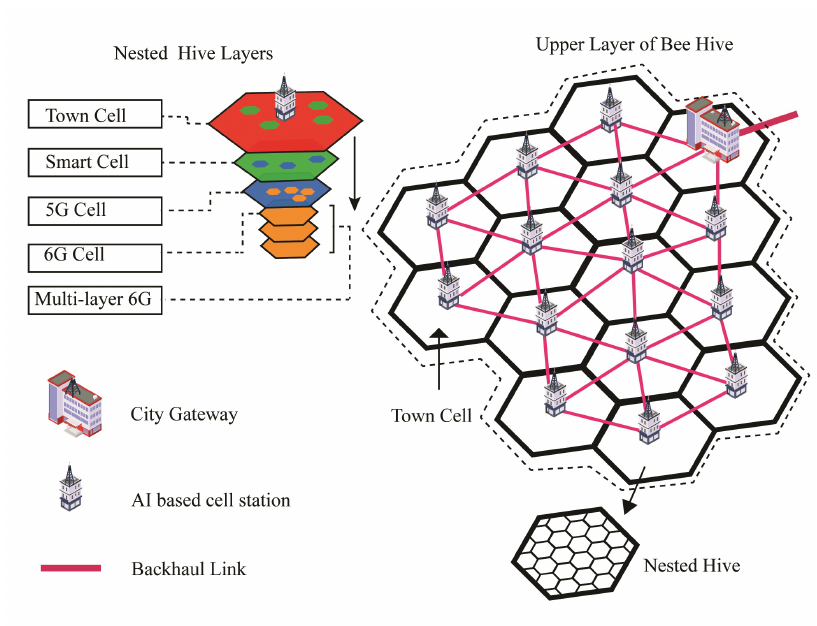
Figure 2. Nested cells distribution view of Bee Hive